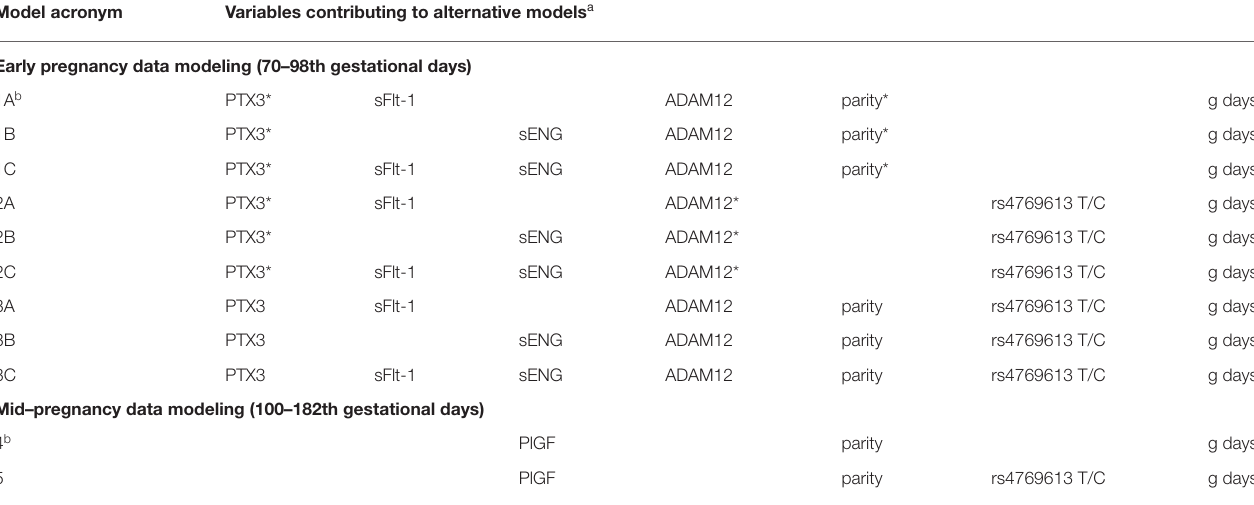
TABLE 4 | Developed PE prognosis models and contributing variables. Model